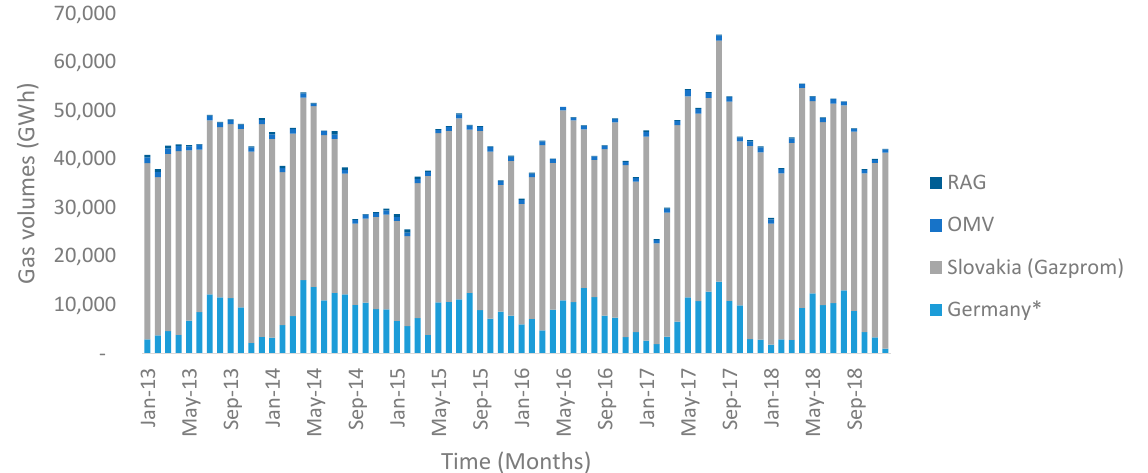
Figure 1. Monthly gas imports to Austria and indigenous production. Source: E-Control. The data related to the imports of gas to Austria and for the indigenous production by OMV and RAG are provided by E-Control and AGGM Austria (https://www.e-control.at/en/ and https://www.aggm.at/en). * Additional suppliers active in the market Area East receive gas from several gas shippers that are active in Germany.